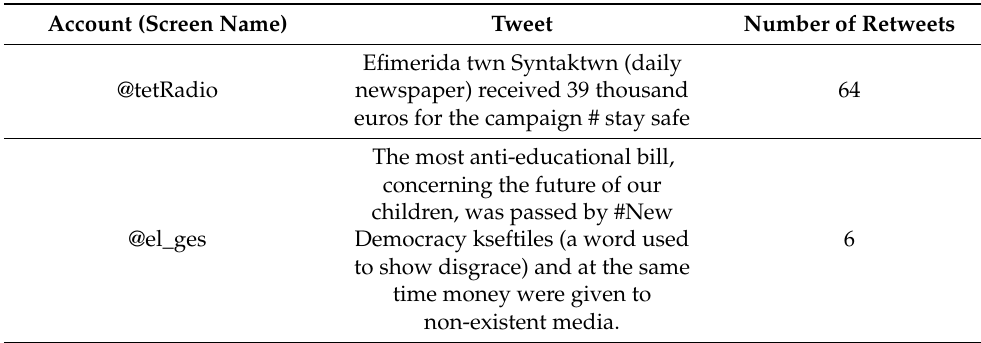
Table 9. Tweets conveying government